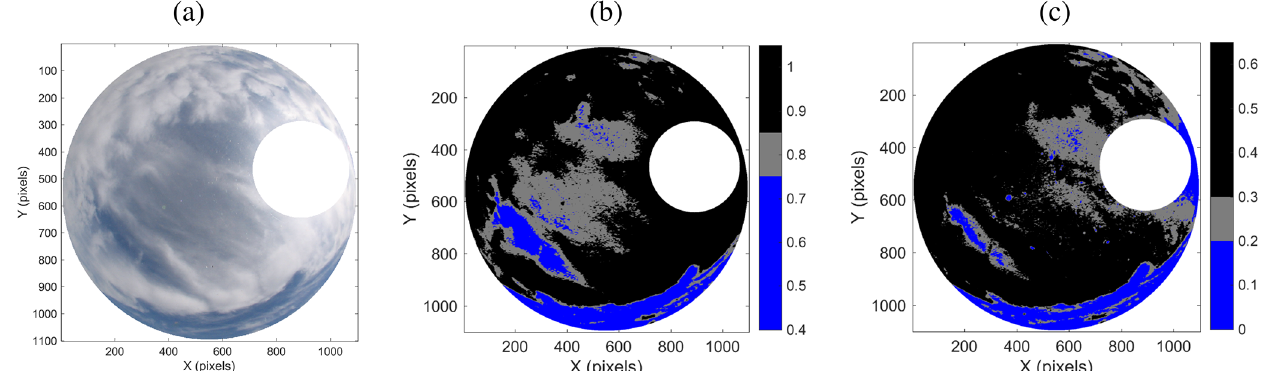
Figure 7. (a) Cropped image of 3 June 2016 at 08:30UTC. (b, c) Result for cloudy, cloud-free, and uncertain pixels from the (b) absolute process and (c) differential process.